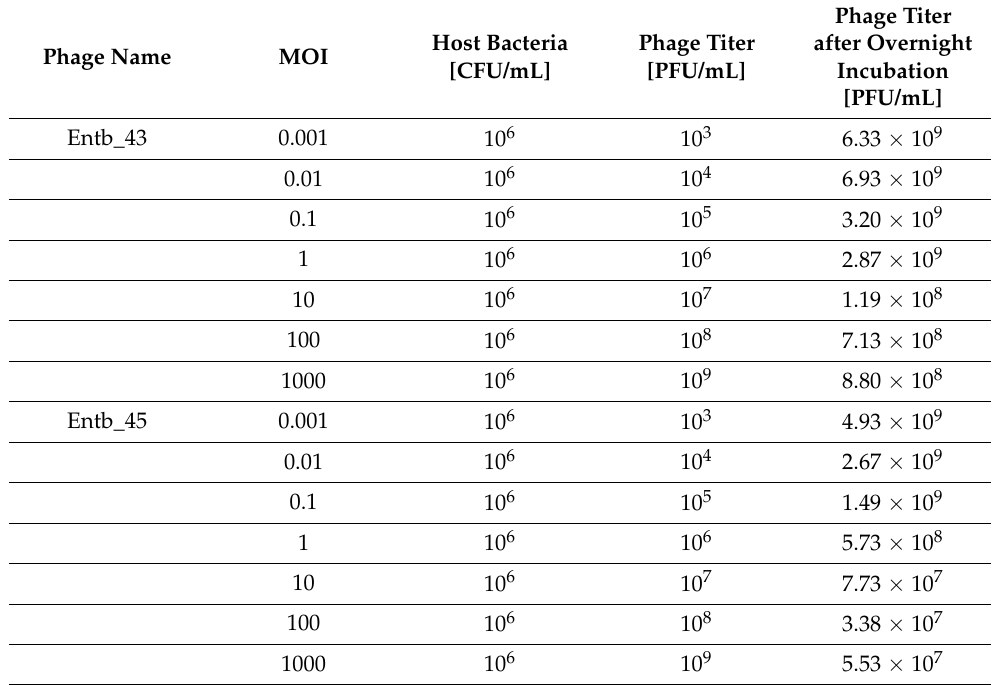
Table 5. Influence of different MOIs on the phage titers after amplification. The final phage titer results reflect the mean of the titers in at least